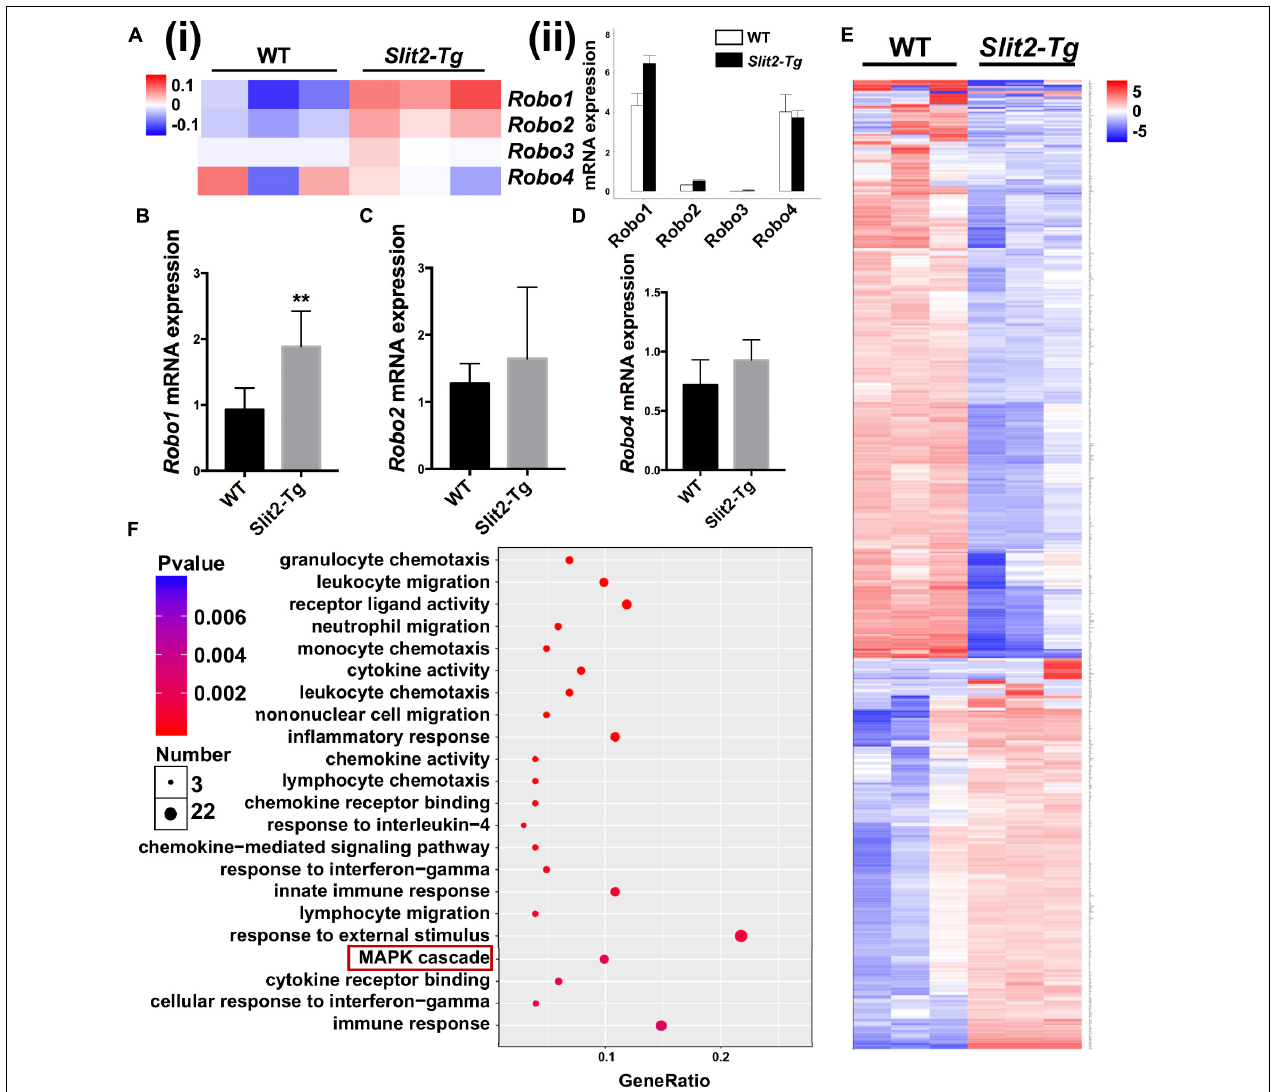
FIGURE 6 | SLIT2/ROBO1 signaling possibly regulates the SLIT2-induced inflammation in periodontitis. (A (i)) Heat map the differential expression of Slit2 receptors Robo1-4 , and (A (ii)) Relative mRNA expression of Robo1 , Robo2 , Robo3 , and Robo4 in PAPT analyzed by RNA sequencing ( n = 3). Relative mRNA expression of, (B) Robo1 , (C) Robo2 , and (D) Robo4 in PAPT analyzed by RT-qPCR ( n = 6). (E) Heat map of differentially expressed 134 mRNAs in PAPT of Slit2-Tg mice to wild-type mice (fdr < 0.05,| FC| > 2). (F) GO pathway enrichment analysis. Data are presented as mean ± SD. The significant difference among the groups, * P < 0.05, ** P <